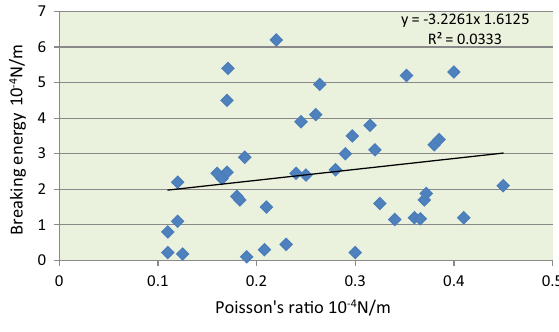
Fig. 8 Relationship between breaking energy and silicate content